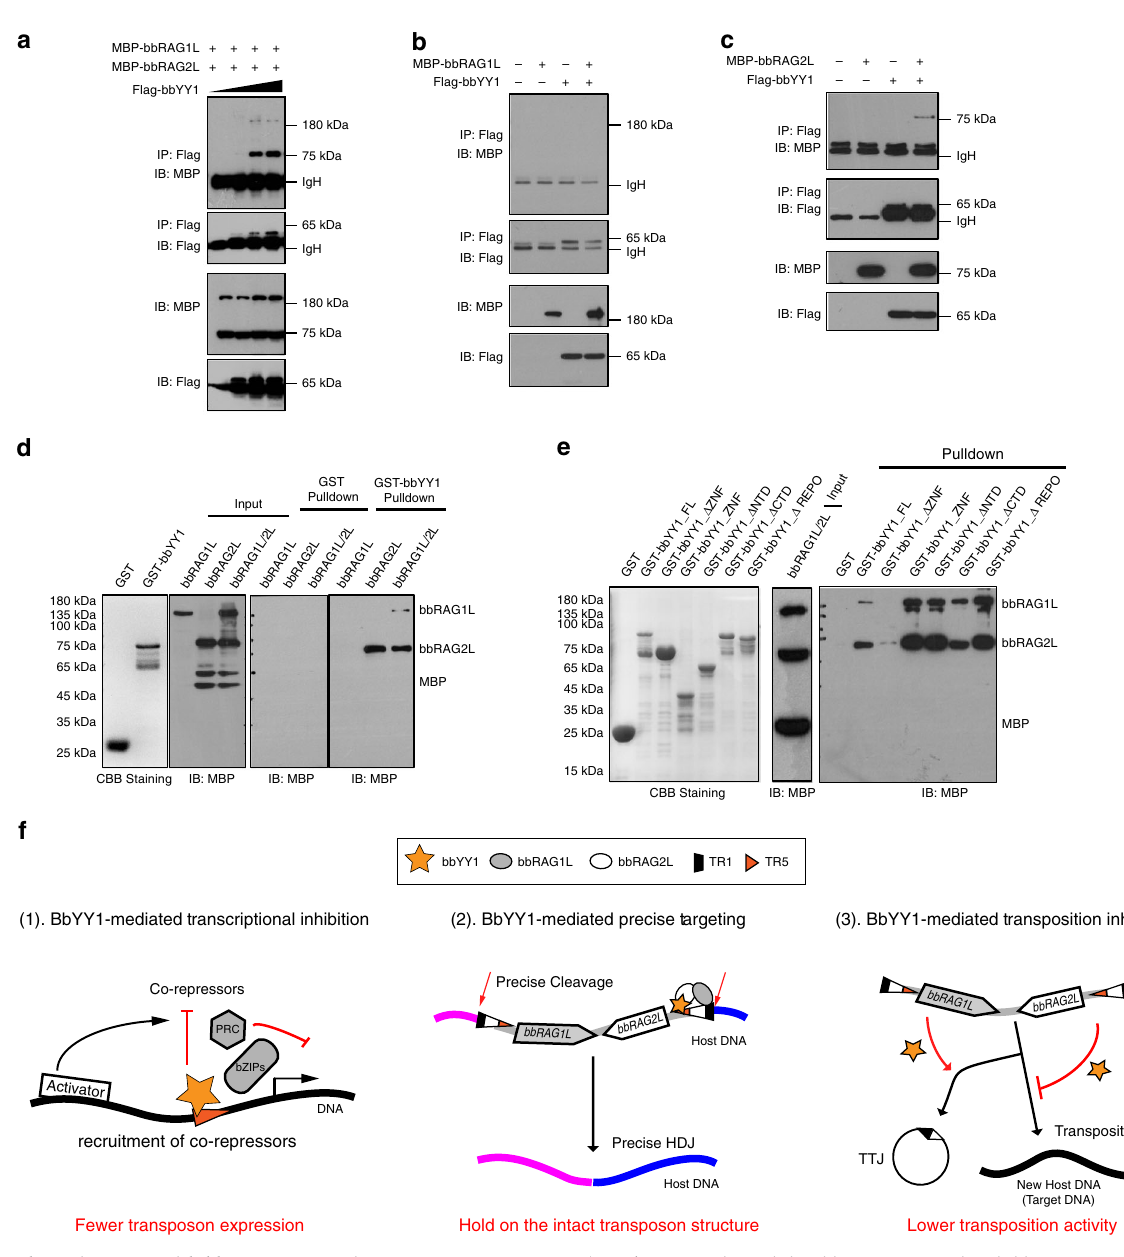
Fewer transposon expression Lower transposition activityHold on the intact transposon structure Fig. 6 BbYY1 interacts with bbRAG1L/2L. a The co-immunoprecipitation (co-IP) assay indicated that bbYY1 interacted with bbRAG1L/2L in a dose- dependent manner. b The co-IP assay indicated that bbYY1 did not interact with bbRAG1L by transfecting MBP-tagged bbRAG1L and Flag-tagged bbYY1 expression vectors into 293T cells. c The co-IP assay revealed the interaction between bbYY1 and bbRAG2L by transfection of MBP-tagged bbRAG2L and Flag-tagged bbYY1 expression vectors into 293T cells. d The GST-pulldown assay indicated the direct interaction between bbYY1 and bbRAG2L (or bbRAG1L/2L complex). e The zinc- fi nger domain (ZNF) of bbYY1 is indispensable for the bbYY1-bbRAG1L/2L interaction. SDS-PAGE and western blotting of the indicated GST-pulldown assays. See also Supplementary Fig. 6E, G. The co-IP and GST-pulldown assays in a – e represent three independent duplications. f A summary diagram illustrates multiple roles of bbYY1 in regulating bbRAG1L and bbRAG2L expression and ProtoRAG -mediated DNA recombination and transposition. First, through recognition of the TR5 element on ProtoRAG , bbYY1 may recruit co-repressors or compete with activators to suppress ProtoRAG transposon expression, contributing to lower transposition activity and a reduced transposition footprint in the lancelet genome. Second, by interacting with bbRAG1L/2L, bbYY1 can mediate bbRAG1L/2L precise targeting to the correct TIR signal sequences, which would lead to precise cleavages and HDJs. Hence, bbYY1 probably protects the intact transposon structure of ProtoRAG against decay. Third, bbYY1 can attenuate TIR- dependent transposition but improves TTJ formation, leading to suppressed transposition activity of ProtoRAG . For a – e , source data are provided as Source Data fi